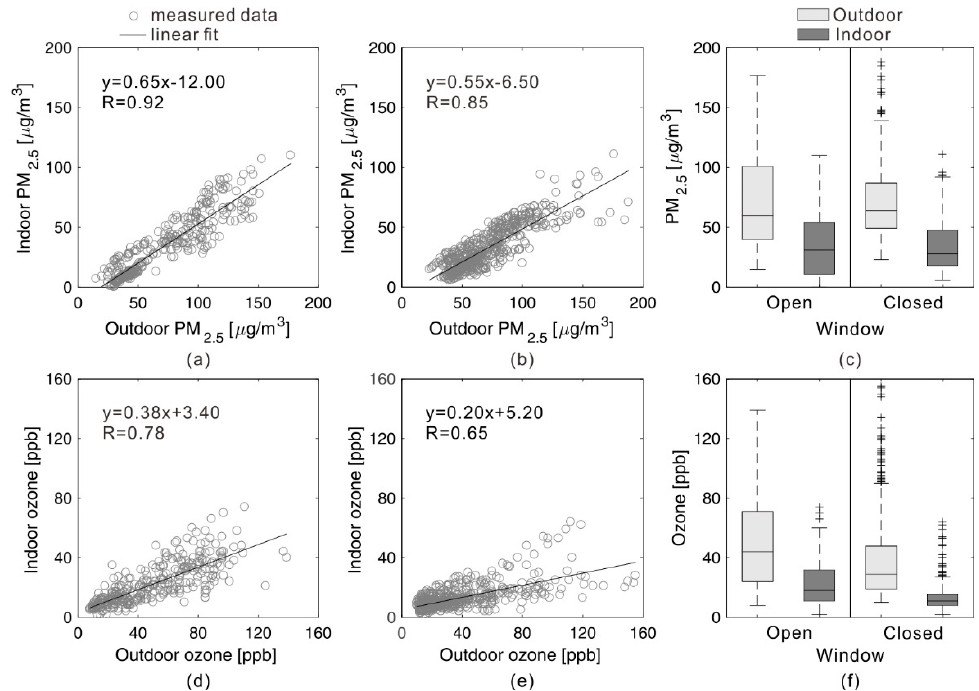
Figure 8. ( a ) Indoor and outdoor concentrations of PM2.5 in the cases of window open status; ( b ) Indoor and outdoor concentrations of PM2.5 in the cases of window closed status; ( c ) The PM2.5 I/O ratio in the cases of window open and closed statuses; ( d ) Indoor and outdoor concentrations of ozone in the cases of window open status; ( e ) Indoor and outdoor concentrations of ozone in the cases of window closed status; ( f ) The ozone I/O ratio in the cases of window open and closed statues. Table 2. I/O ratios of PM2.5 and ozone in the case of window closed and open.